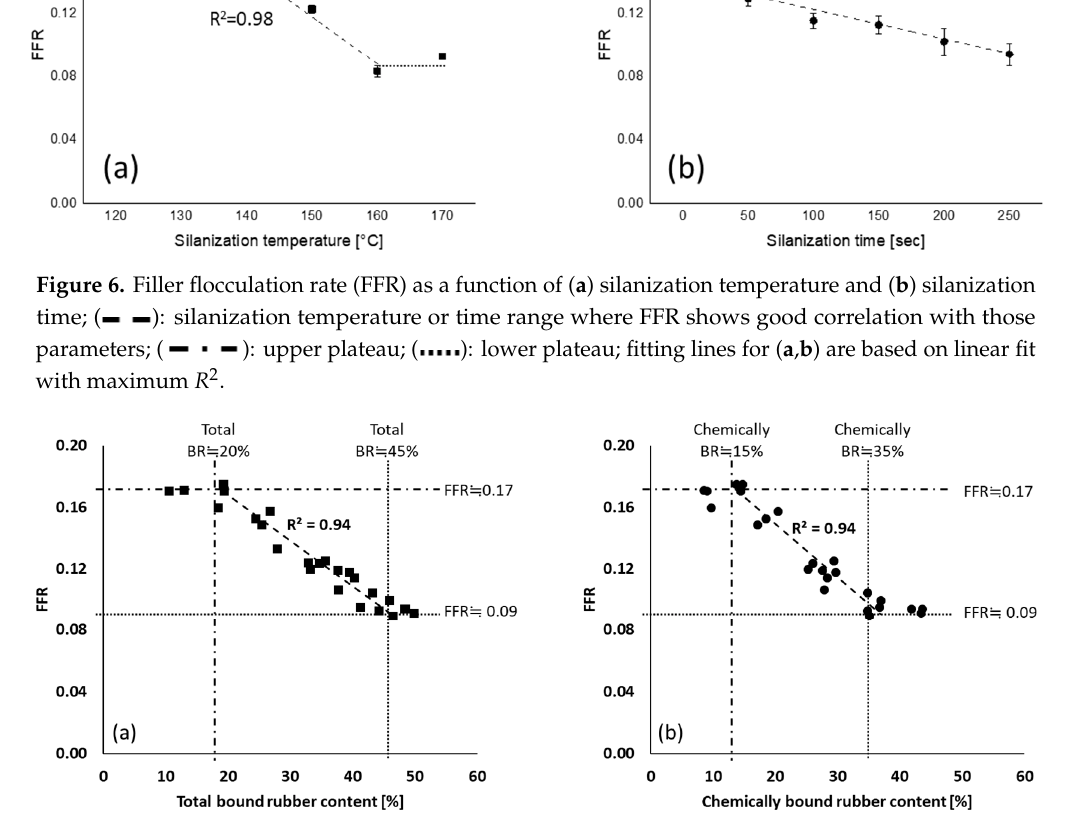
Figure 6. Filler flocculation rate (FFR) as a function of ( a ) silanization temperature and ( b ) silanization